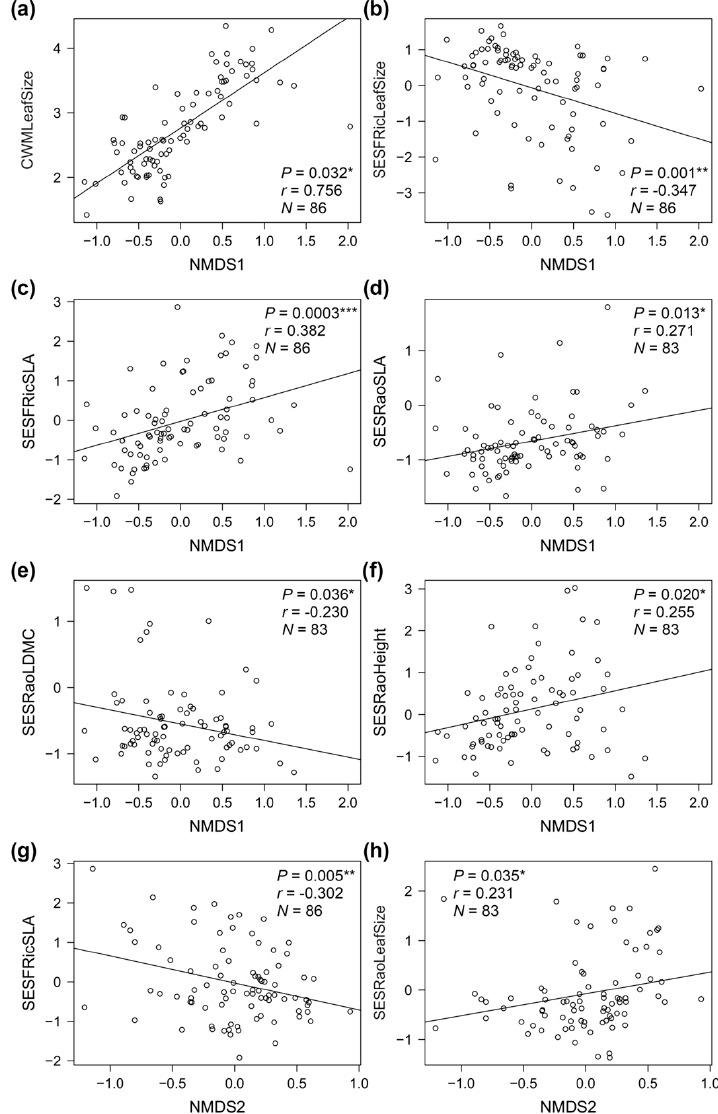
Figure 3. Scatter plot representing the significant relationships that were found between the functional composition (CWM), standardized effect size of functional richness (SESFRic) and diversity (SESRao) of the traits that were studied (LDMC: leaf dry matter content, SLA: specific leaf area, leaf size, and plant height), and taxonomic composition (expressed as the first and second ordination axes scores that were given by the NMDS) ( a – h ). The regression line and r (Pearson’s correlation coefficient), N (number of plots), and p -values (statistical significance of the correlation) are shown. ‘.’ = p > 0.05; ‘*’ = 0.01< p < 0.05; ‘**’ = 0.001< p < 0.01; ‘***’ = p < 0.001.